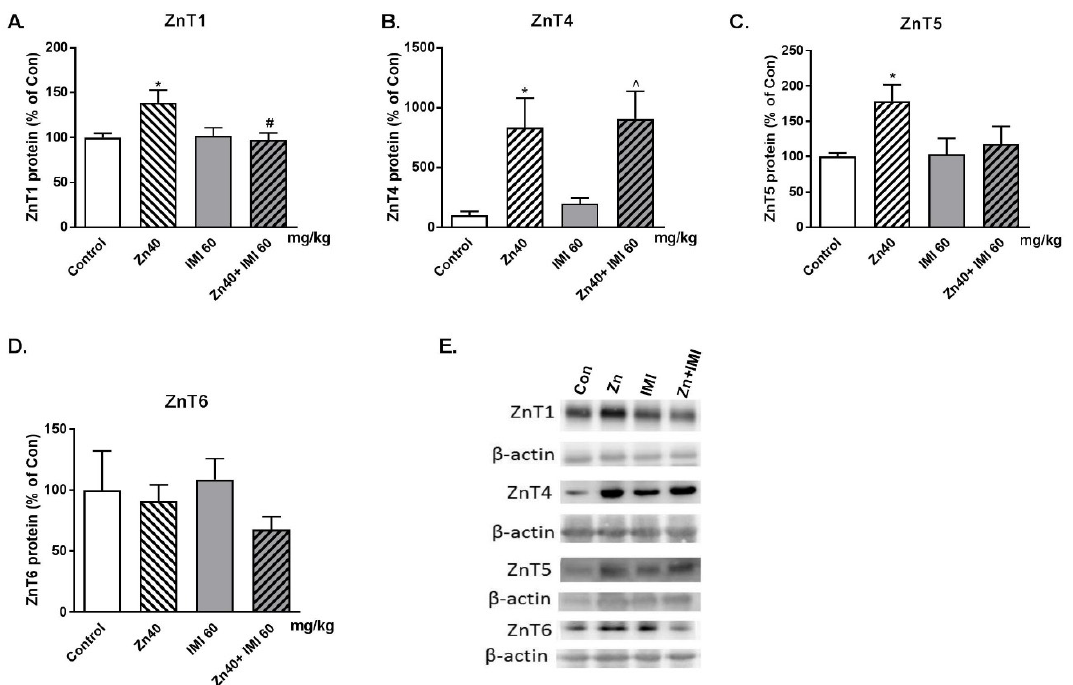
Figure 4. Western blot analysis of the effect of co-treatment of Zn (40 mg Zn/kg), IMI (60 mg/kg), and NaCl (control) administered p.o. on the protein levels of Zn transporters: ( A ) ZnT1, ( B ) ZnT4, ( C ) ZnT5, and ( D ) ZnT6 in the mouse small intestine. Representative western blots ( E ). Results are expressed as mean ± S.E.M (n = 5–7 per group). * p < 0.05 vs. control group, # p < 0.05 vs. Zn group, ^ p < 0.05 vs. IMI group (two-way ANOVA followed by Tukey post-hoc test).